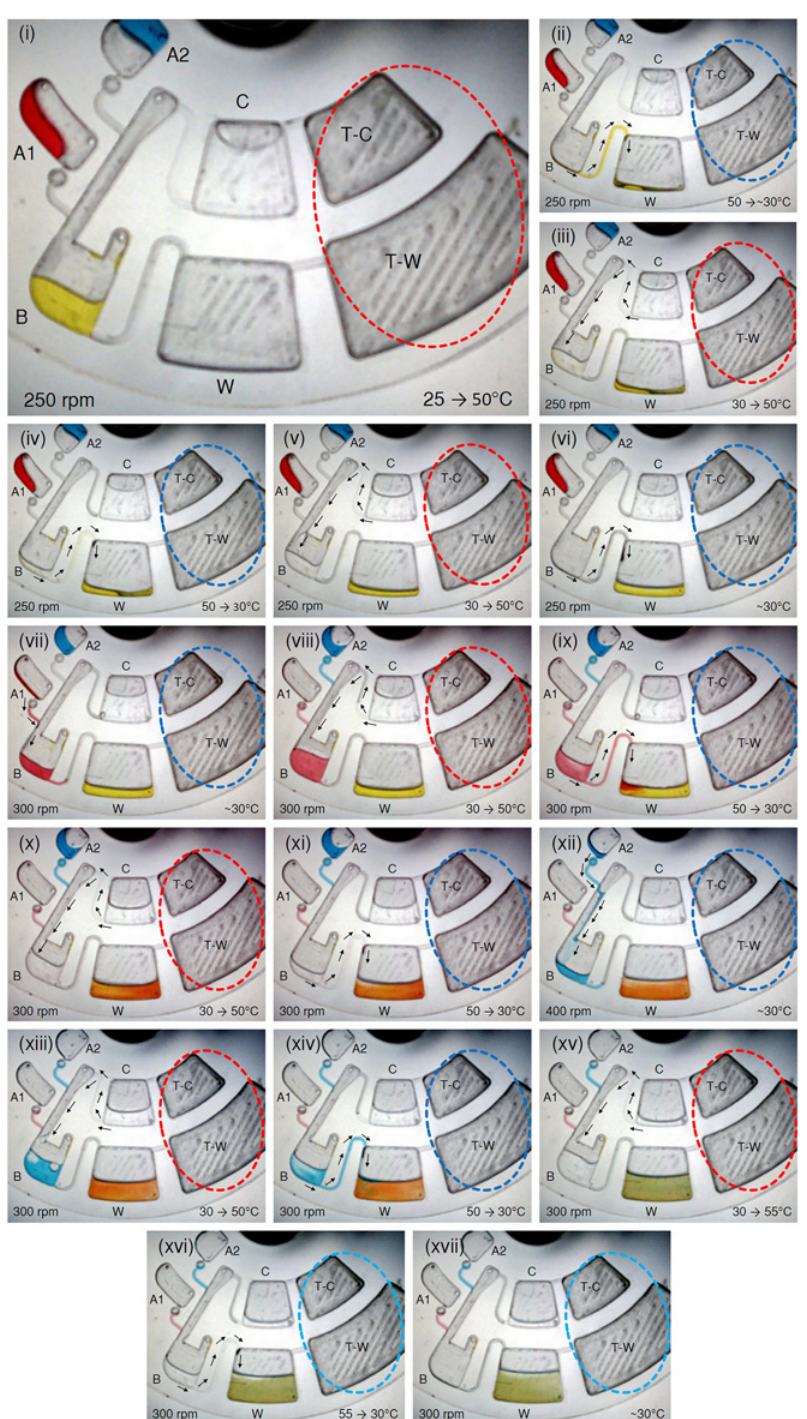
Fig 5. Demonstration of biosensor chamber push-wash and pull-evacuation for an immunoassay. (i) Yellow (representing test sample containing target antigen), Red (representing blocking solution), Blue (representing fluorescent labelled secondary antibodies) liquids, and de-ionized water (representing washing solution) are respectively loaded into biosensor chamber B, source chambers A1 and A2, washing solution chamber C. (ii — vi) Yellow liquid is pull-evacuated into waste chamber W, wash solution chamber is sealed and biosensor chamber is washed twice. (vii — xi) Red liquid is burst into biosensor chamber B, followed by